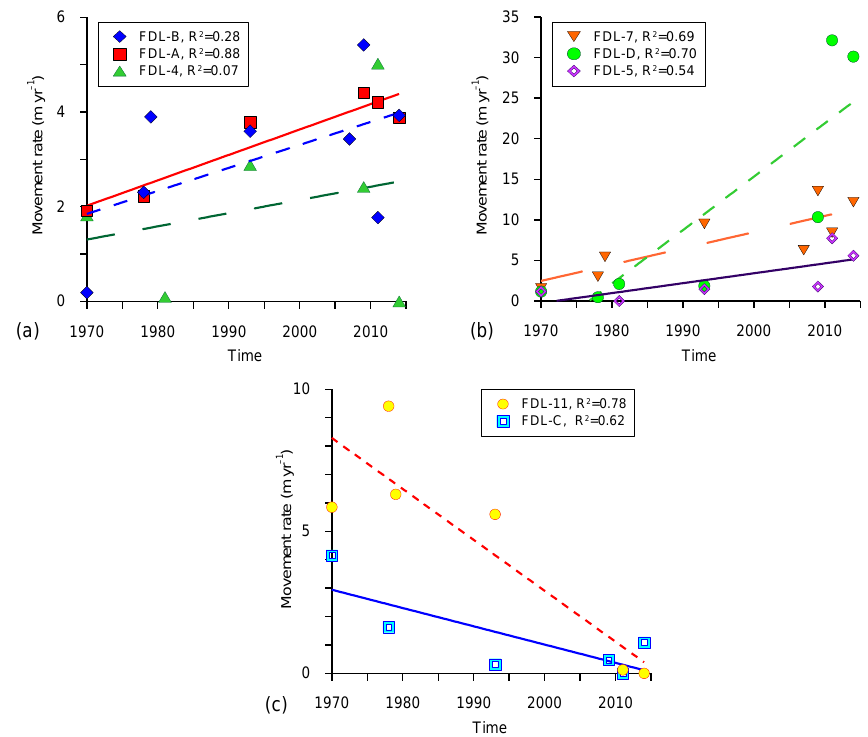
Figure 8. Historic FDL movement rates from 1955 to 2014 for lobes with (a) steadily increasing rates, (b) rapidly increasing rates, and (c) decreasing rates. The coefficient of correlations ( R 2 ) for linear trend lines fitted to each lobe data set are presented in the figure legends.